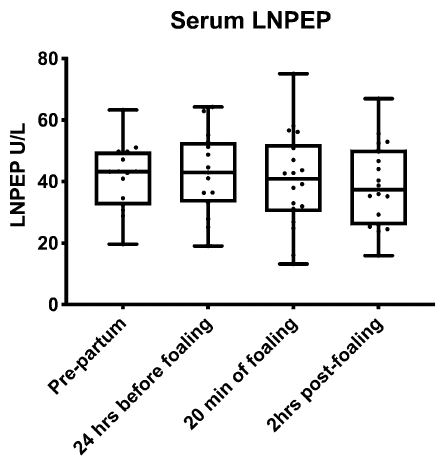
median serum LNPEP concentration (U/L) and interquartile range (IQR) at sampling times were: pre-partum 43.2 (32.2, 49.8), 24 h to foaling 42.9 (33.1, 52.8), within 20 min after foaling 40.87 (30, 52.2), and 2 h post-foaling